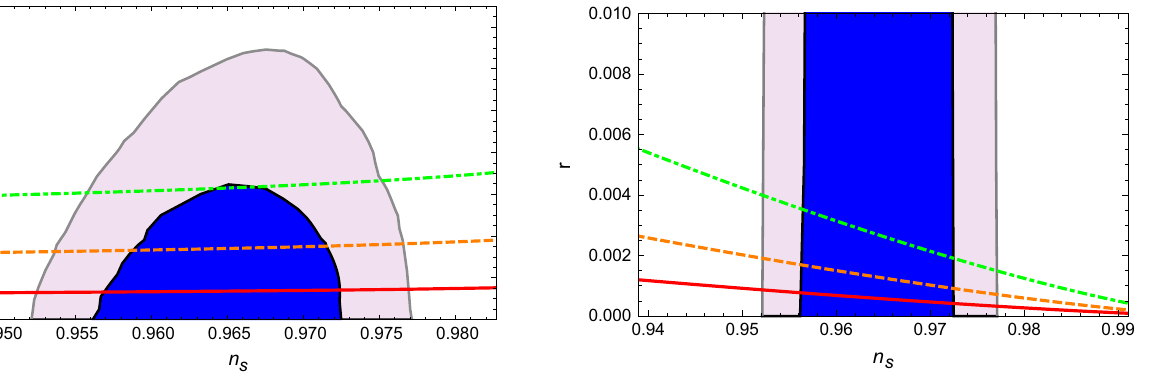
Fig. 1 1 σ and 2 σ confidence regions which borrowed from Planck [1,23], r − n s trajectories of the present model in the strong dissipative regime. The solid red, dashed orange and dot-dashed green lines corre- spond to Γ 0 values: 1 . 82 × 10 − 1 . 64 , 1 . 54 × 10 − 1 . 64 and 1 . 38 × 10 − 1 . 64 . In these curves we have fixed (ξ 2 , C γ ) as: (10 8 λ, 70) and the number of e-folds as: N e = 60